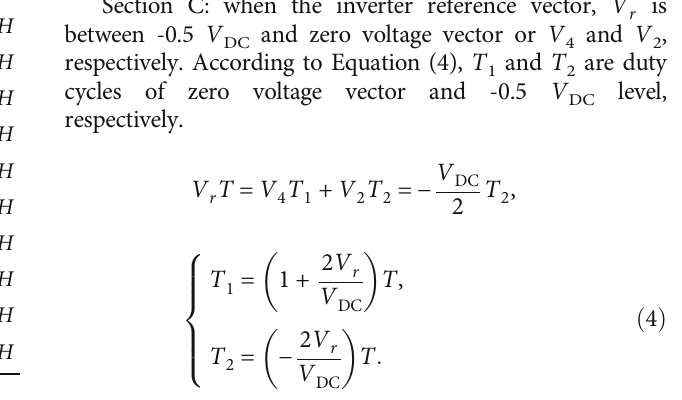
Section D: when the amplitude of the inverter reference voltage is between -0.5 V V